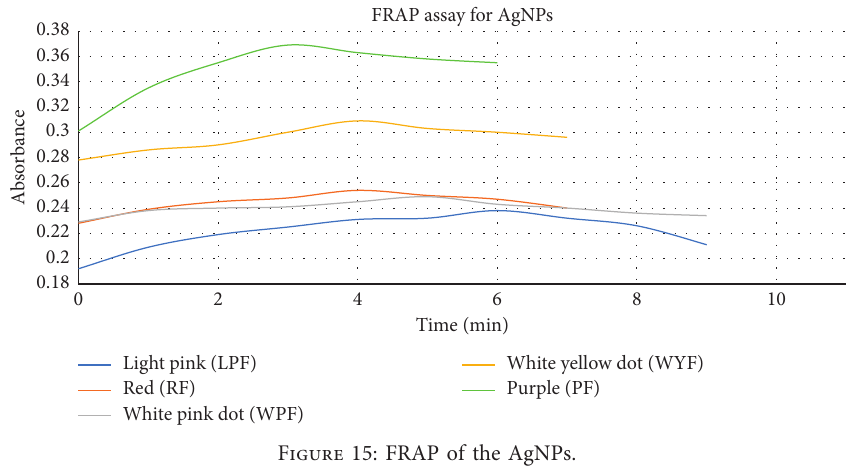
Figure 15: FRAP of the